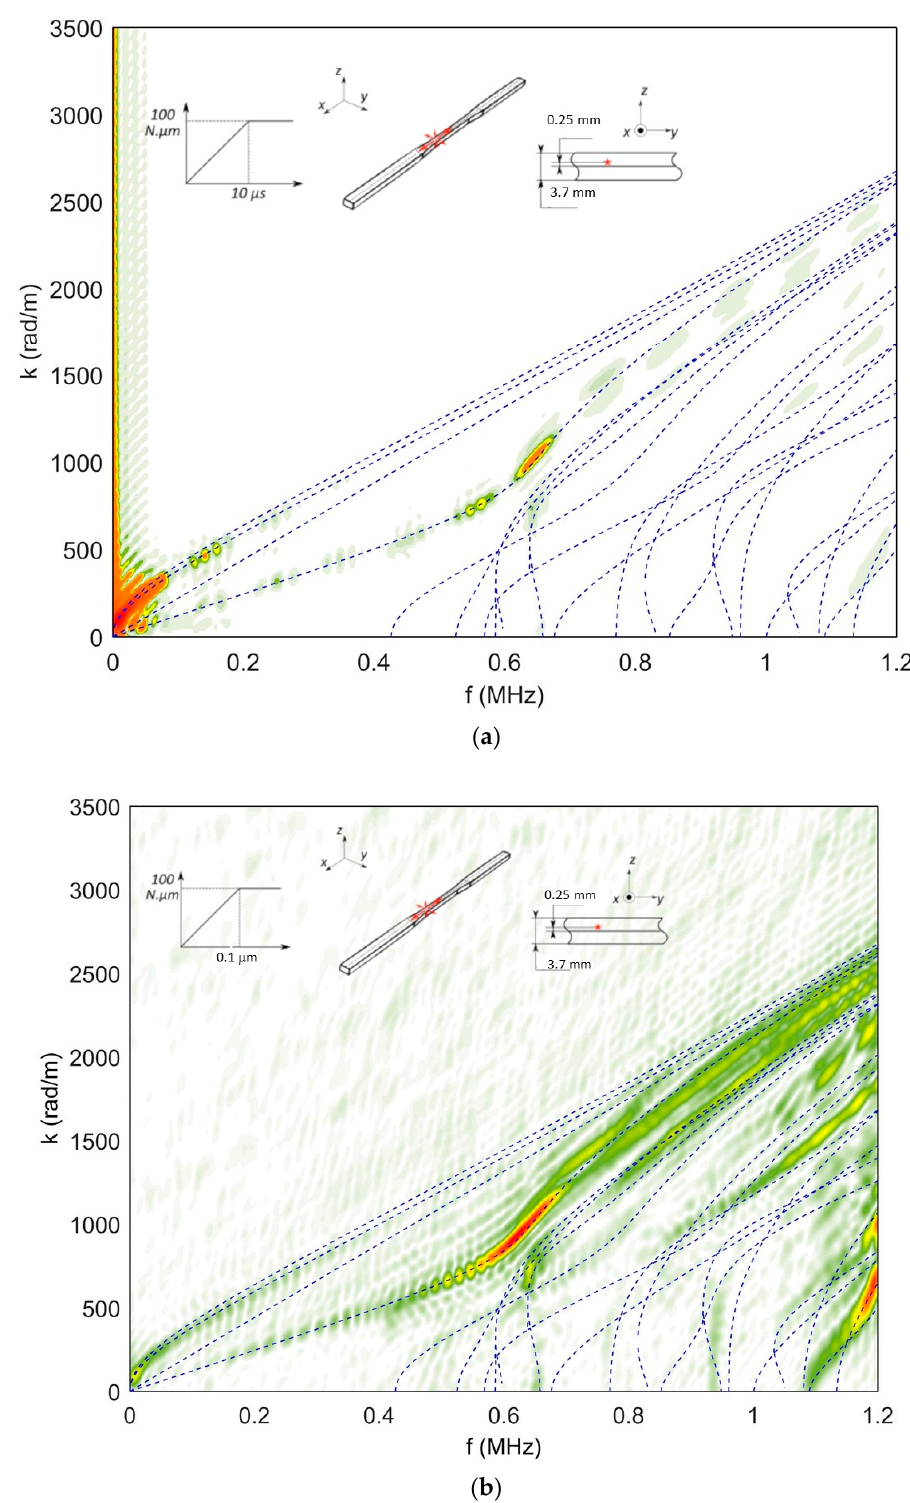
Figure 11. 2DFT (wavenumber k versus frequency f ) of simulated signals for the EPL3 specimen stimulated by sources D 1 (M x = 100 N ∙μ m, 0.25 mm, 10 μ s) ( a ), and D 1 (M x = 100 N ∙μ m, 0.25 mm, 0.1 μ s) ( b ).